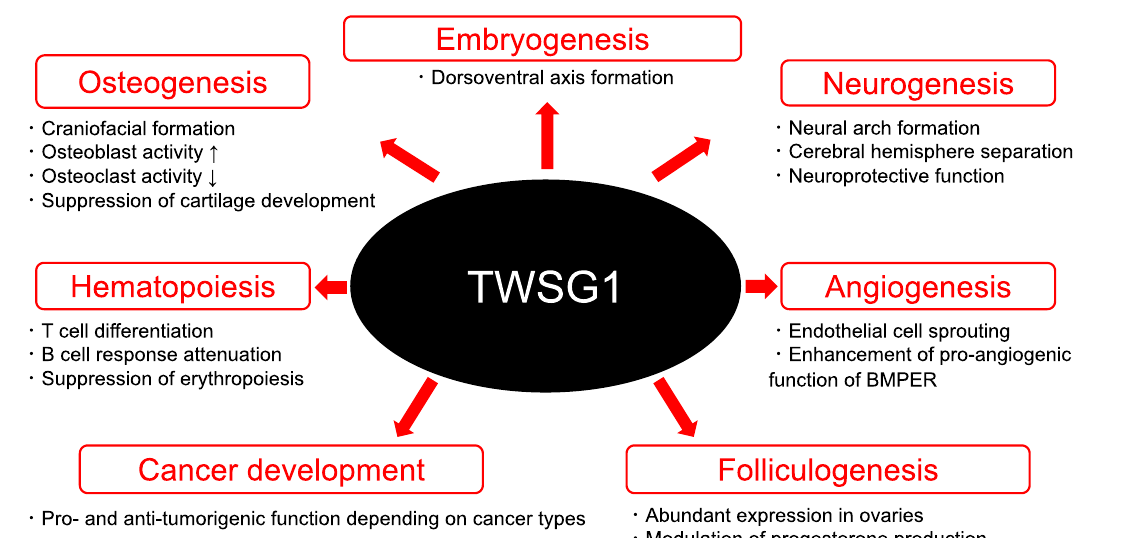
Figure 2. The multifaceted functions of TWSG1. TWSG1 has a wide range of functions from embryogenesis to cancer development.